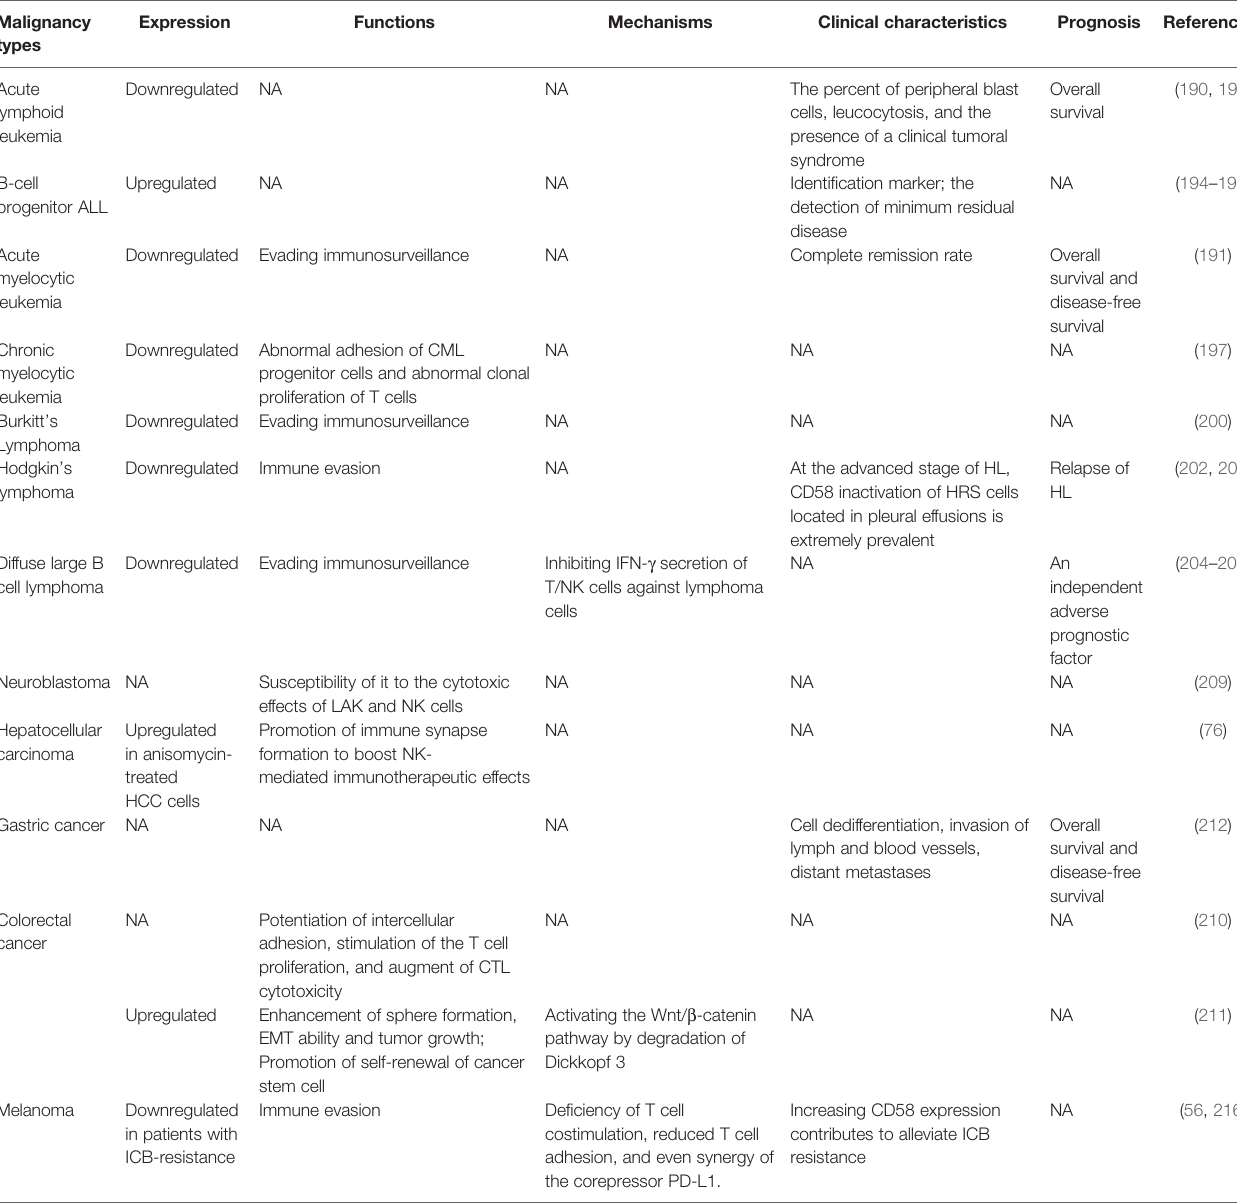
TABLE 1 | Expression, function and clinical signi fi cance of CD58 in various